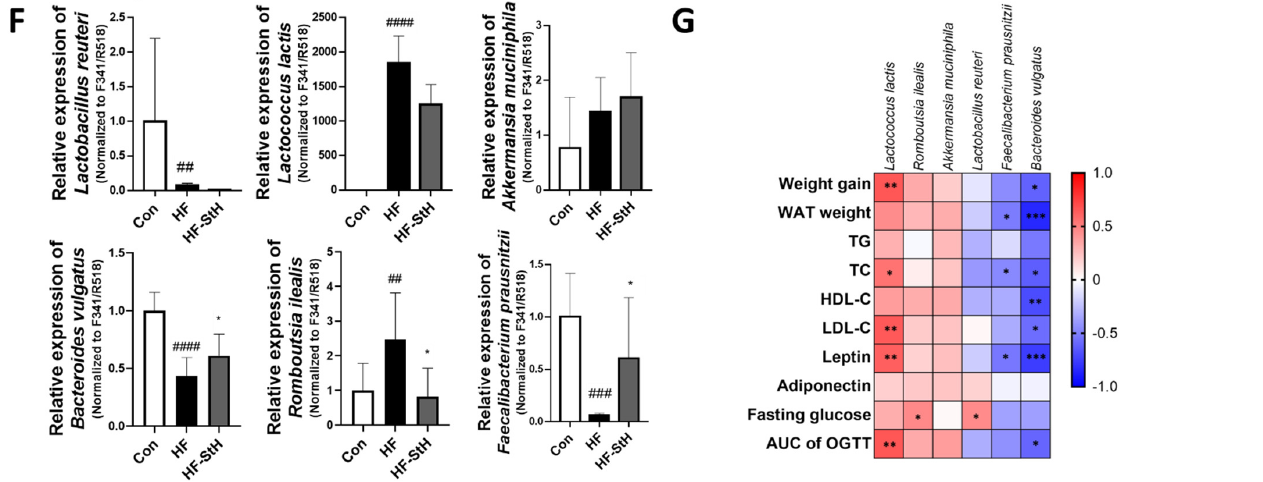
Figure 8. Effects of S. thunbergii (ST) extract on the gut microbiota composition in high-fat-fed C57BL/6 mice. ( A ) Shannon evenness and observed ASVs richness diversity. ( B ) Principal coordinate analysis (PCoA) of weighted UniFrac distances. ( C ) Taxonomy community analysis at phylum and genus level. ( D ) The ratio of Firmicutes to Bacteroidota. ( E ) Specific taxa whose relative abundance was changed by high-fat diet or treatment (n = 2; fecal DNA from 5 mice were pooled into a sample for 16S sequencing). ( F ) Quantitative PCR results for selected bacterial groups. The relative abundance of bacterial groups was expressed as a ratio of total bacteria (F341/R518). Data are expressed as means ± SD (n = 10/group). Con: chow diet, HF: high-fat diet, HF-StL: high-fat diet+ST extract 150 mg/kg bw, HF-StH: high-fat diet+ST extract 300 mg/kg bw. Compared between the control and the high-fat diet group; # p < 0.05, ## p < 0.01, #### p < 0.0001 by non-parametric Kruskal–Wallis test. Compared between the high-fat diet and the experimental group, ⁎ p < 0.05 by non-parametric Kruskal–Wallis test. ( G ) Correlation analysis of gut microbial species and obesity-related markers (Spearman correlation; * p < 0.05, ** p < 0.01, *** p < 0.001).